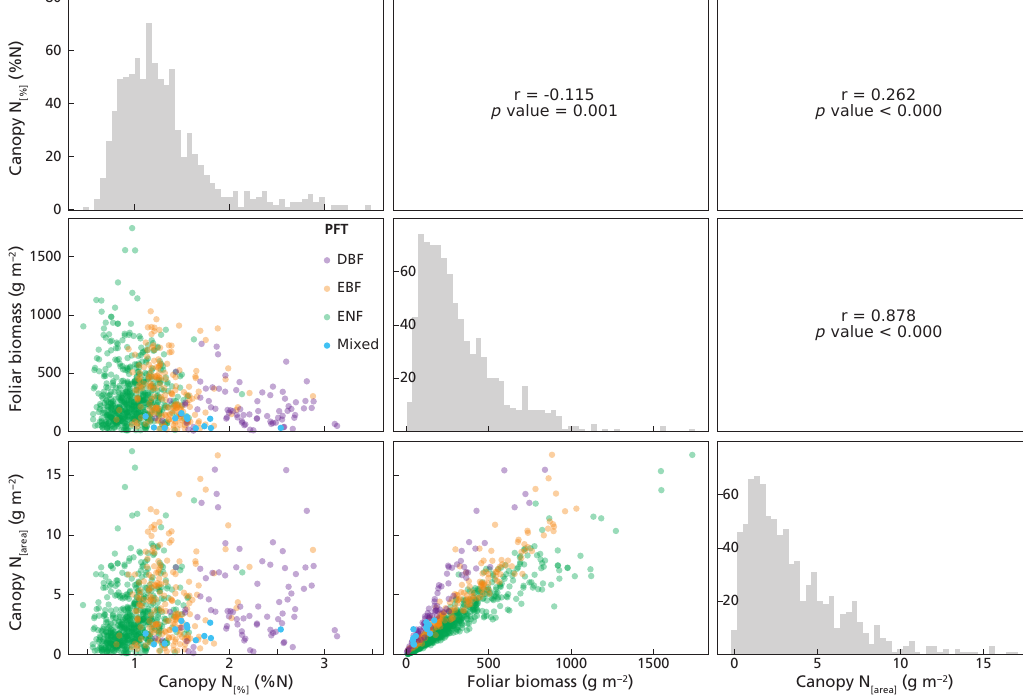
Figure 3. The upper right part of this figure shows the Pearson correlation matrix between canopy N [ % ] (%N), canopy N [ area ] (gm − 2 ) and foliar biomass (gm − 2 ) variables for the whole dataset, n = 841. The diagonal presents the histograms of the variables on the x axis, while the y axis represents the number of counts. The lower left part of this figure represents the scatterplots between the variables. PFT is plant functional type, DBF is deciduous broadleaf forest, EBF is evergreen broadleaf forest, ENF is evergreen needleleaf forest, and mixed is mixed forest.